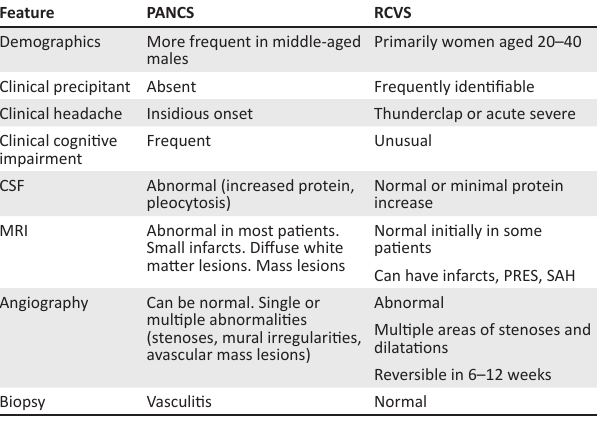
TABLE 3: Useful list of features distinguishing RCVS from PANCS.